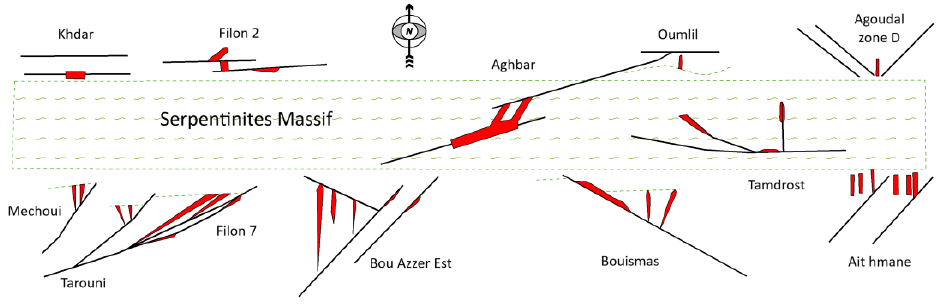
Figure 4. The Bou Azzer arsenide vein system modified after